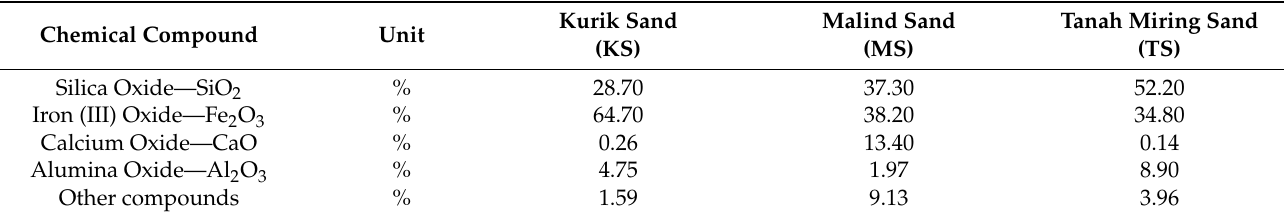
Table 2. Chemical compounds in pit